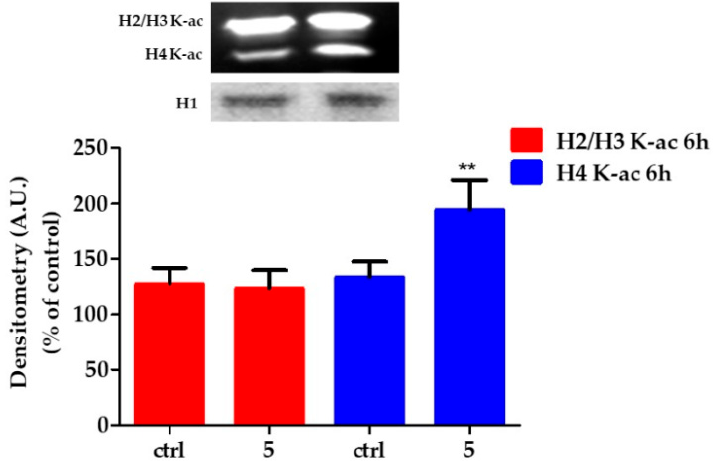
Figure 5. Changes in the state of histone acetylation. Above). Representative micrographs are shown of Western Blot of acetylated histones. Below). Relative quantification of H2/H3 acetylated histones in HT29 control and exposed to 5 µ M compound 5 for 6 h. Arbitrary densitometry units (A.U.) were normalized by H1 histone. Results are given as means ± SD of three independent experiments and are compared to controls, taken as 100%. (** p = 0.0045). HT29 treatment with 5 for 6 h induced different effects on histones acetylation. In particular, 5 induced H4 hyperacetylation, while it did not modify the state of acetylation of H2/H3.